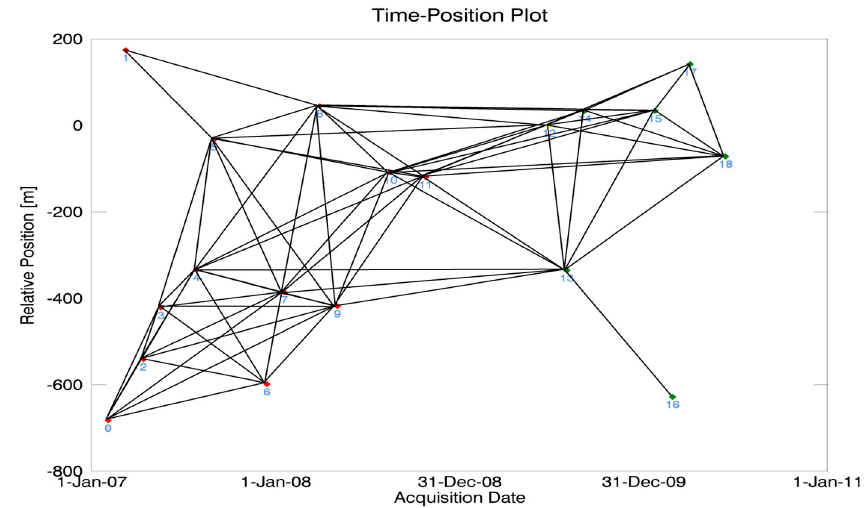
Figure 6. Connection graph of ENVISAT ASAR pairs during 2007–2010 for SBAS processing in StaMPS